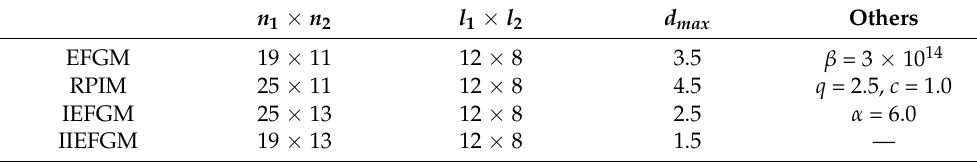
Table 1. Optimal computing parameters of each method within the tested